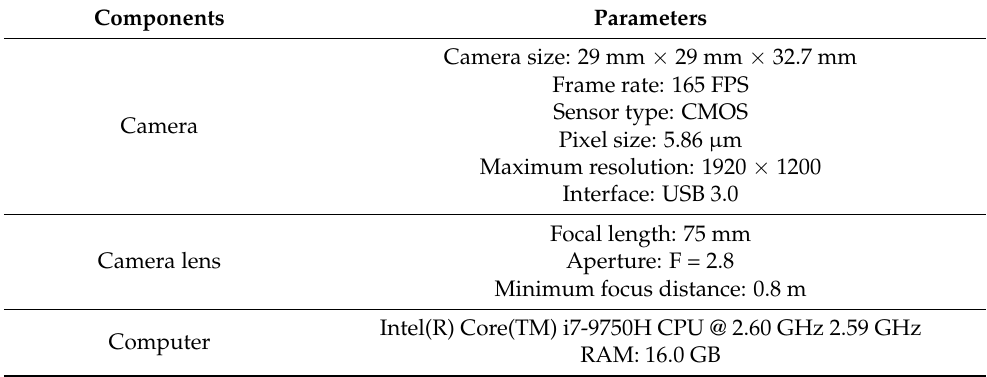
Table 1. The parameters of the displacement measurement